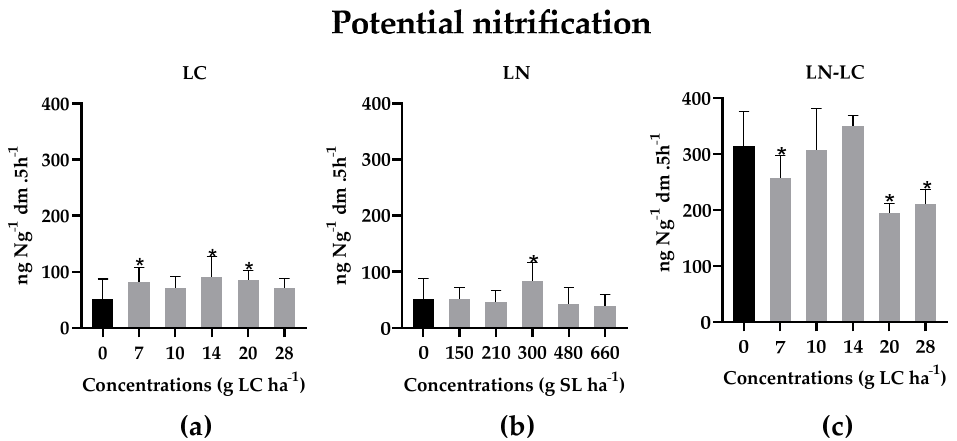
Figure 8. Nitrification potential activity in soils exposed for 15 days to different concentrations of LC ( a ), LN ( b ), and LN–LC ( c ). The concentrations tested are based on the amount of LC. In the case of LN, the concentrations indicated are of solid lipid (SL) used in the synthesis of LN. The same concentrations of SL were tested for LN–LC. Results are represented by mean ± SD values. Asterisks mark the significant differences in relation to the control group (0 g LC ha − 1 ) ( p < 0,05, Dunnett).